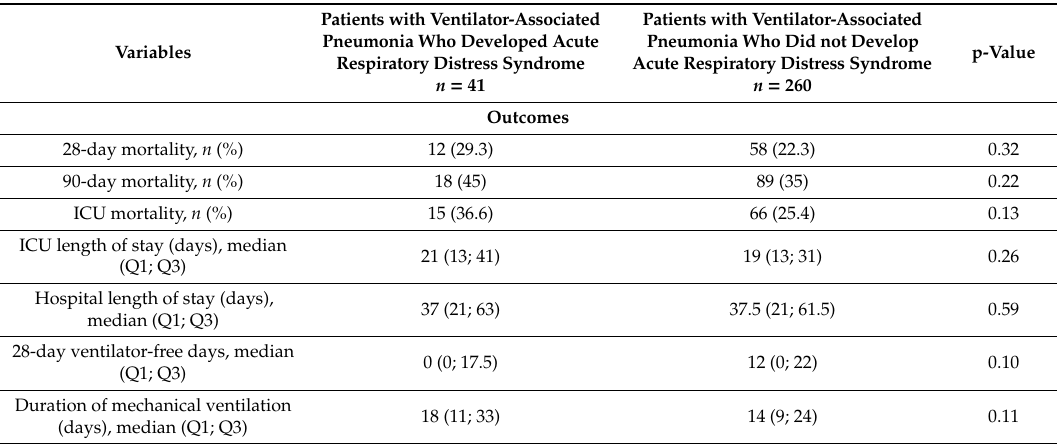
Table 3. Clinical outcomes.